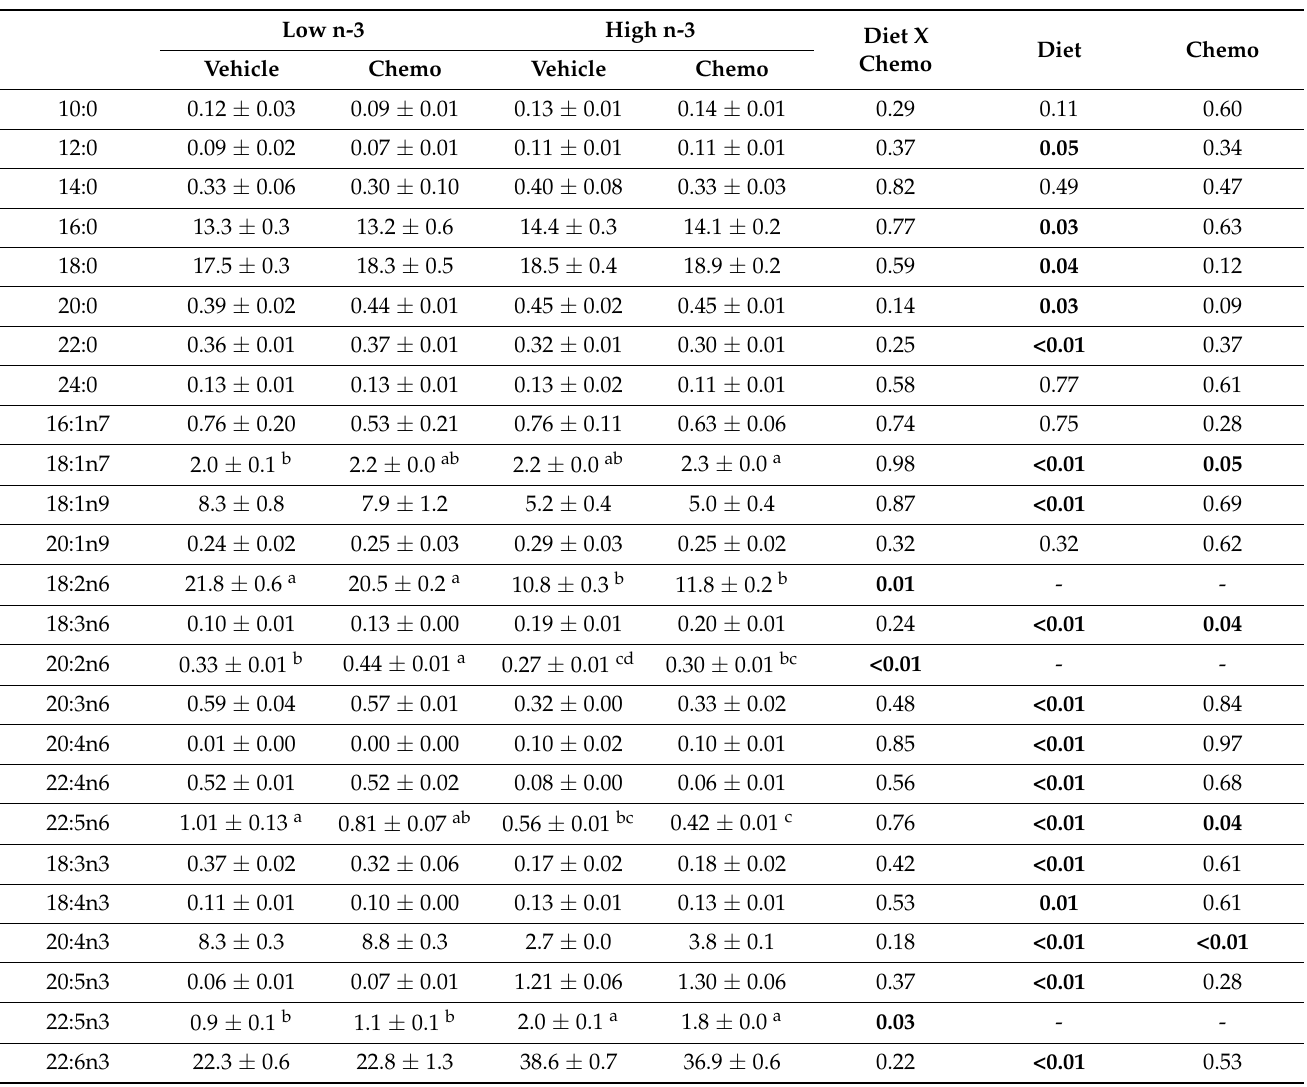
Table 1. Heart fatty acid composition (reported as a percent of total fatty acid detected). Data presented as group means ± SEM ( n = 4/group). A two-way ANOVA with a diet x chemo interaction was used to detect differences between factors while pairwise comparisons were performed using a Tukey’s post hoc test. p < 0.05 are in bold and group means with different letters (a, b, c)